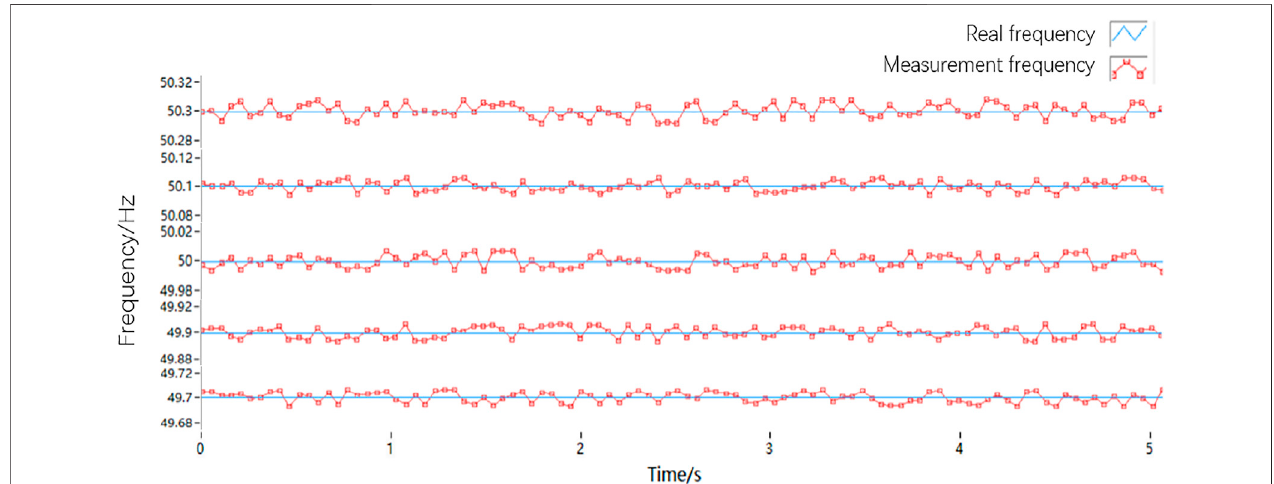
FIGURE 10 | Frequency measurement fi